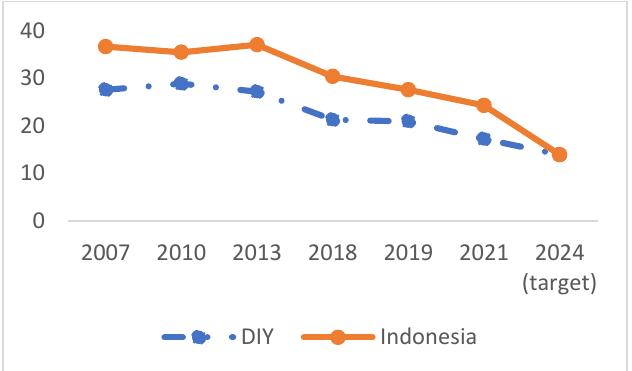
Figure 2. Trends of under five stunting prevalence in Yogyakarta Province (2007–2021).